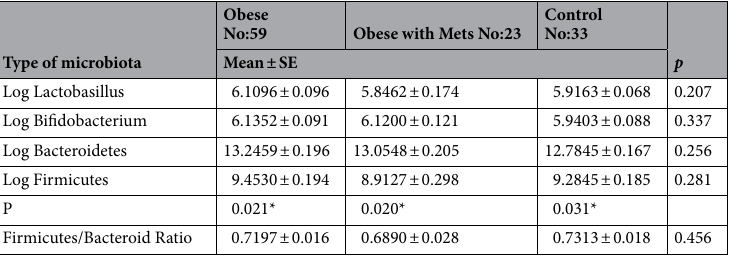
Table 2 showed the mean ± SE of biochemical parameters of the three studied groups. The obese women with MetS had the significant highest values for the liver enzymes [Aspartate aminotransferase (AST) and the Alanine aminotransferase (ALT)], fasting blood glucose, insulin, and serum lipid profile; except the HDL-C which showed the insignificant lowest value compared to both the obese women without MetS and the control. The mean value of the C-reactive protein had the highly significant highest value among the obese women without MetS. The mean serum concentration of leptin hormone in the obese women with Mets was the significantly lowest compared to the other two groups. SCFA was insignificantly the highest among the obese women with MetS. Table 3 showed the mean ± SE of the log number and types of Microbiota among the three studied groups. Bacteroidetes bacteria were the most prevalent type among them, followed by the bad gut microbes Firmicutes, while Lactobacillus and Bifidobacteria were the least prevalent. There were significant differences between the log numbers of the 4 types of studied microbiota in the three groups at p ≤ 0.021, 0.020, 0.031 respectively. However, insignificant difference was found between the three studied groups, as regard the Firmicutes/Bacteroidetes Ratio